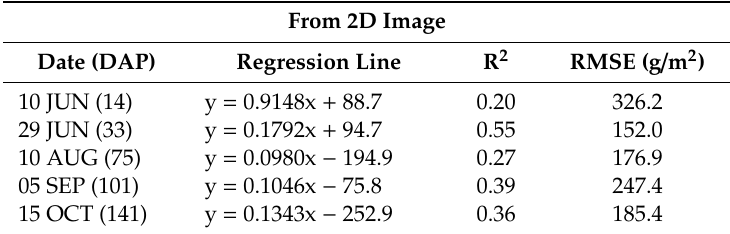
Table 1. The comparison of sweet potato dry weight and estimated LAI based on 2D images. From 2D Image